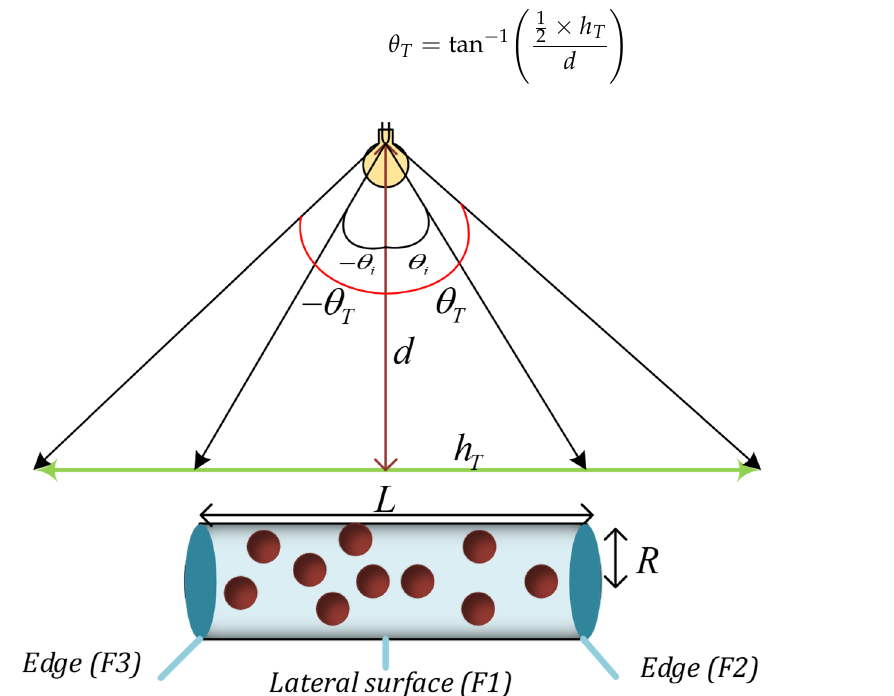
Figure 5. A schematic of how LEDs radiate to the optical antenna. In Equation (2), L represents the length of the